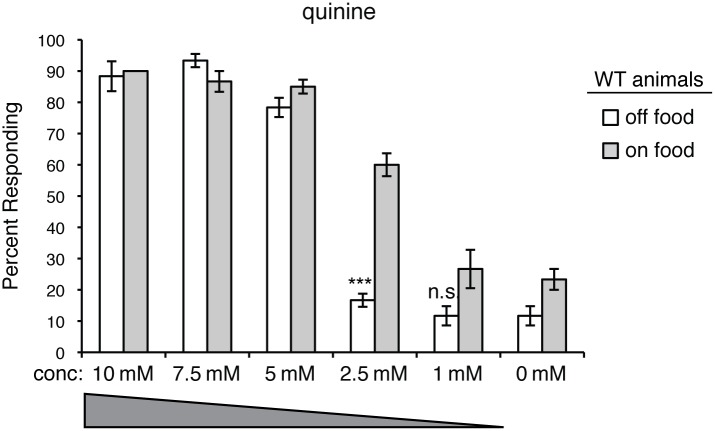
Response to quinine is modulated by feeding status.The response of wild-type animals to dilute quinine diminishes upon food deprivation (p < 0.00001 for 2.5 mM when comparing animals assayed “off food” versus “on food”). The percentage of animals responding is shown. The combined data of n ≥ 60 animals is shown for each concentration. Animals were assayed 10–20 minutes after transfer to plates with or without food (no bacterial lawn). conc = concentration. n.s. = not significant. WT = the N2 wild-type strain.